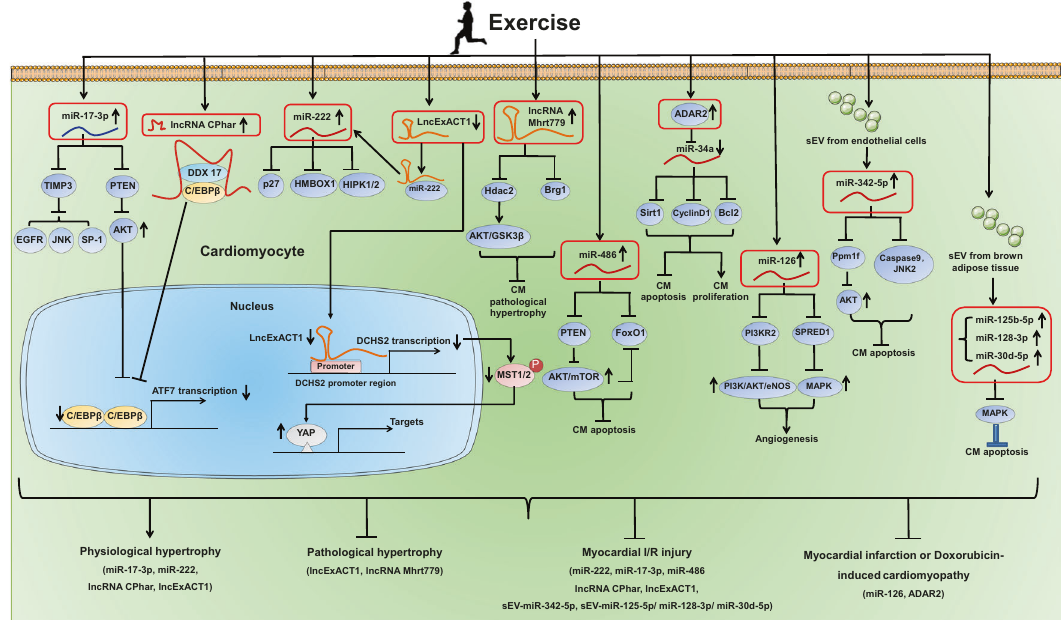
Fig. 6 Noncoding RNAs and their regulated pathways in exercise-induced physiological cardiac hypertrophy and cardioprotection. Exercise upregulates miR-222 (targeting p27, Hmbox1, HIPK1/2) and miR-17-3p (targeting PTEN and TIMP3) in the heart. Exercise also upregulates lncRNA CPhar while downregulates lncExACT1 in the heart. LncRNA CPhar acts as a binding partner of DDX17 which sequesters C/EBP β , thus leading to reduced transcription of ATF7. LncExACT1 is able to bind miR-222, while exercise-induced downregulation of lncExACT1 frees more miR-222 which contributes to exercise-induced physiological cardiac hypertrophy. LncExACT1 also positively regulates its closest protein- coding gene DCHS2 and reduced lncExACT1 activates YAP. Targeting these noncoding RNAs contributes to exercise-induced physiological cardiac hypertrophy and exerts protective effects against myocardial I/R injury and pathological cardiac hypertrophy. Exercise also regulates other noncoding RNAs including lncRNA Mhrt779, miR-486, ADAR2-regualted miR-34a, and miR-126, and induces endothelial cell-derived small extracellular vesicles (sEV) containing miR-342-5p and brown adipose tissue-derived sEV containing miR-125b-5p, miR-128-3p, and miR- 30d-5p in the heart, which protect against myocardial injury and cardiac